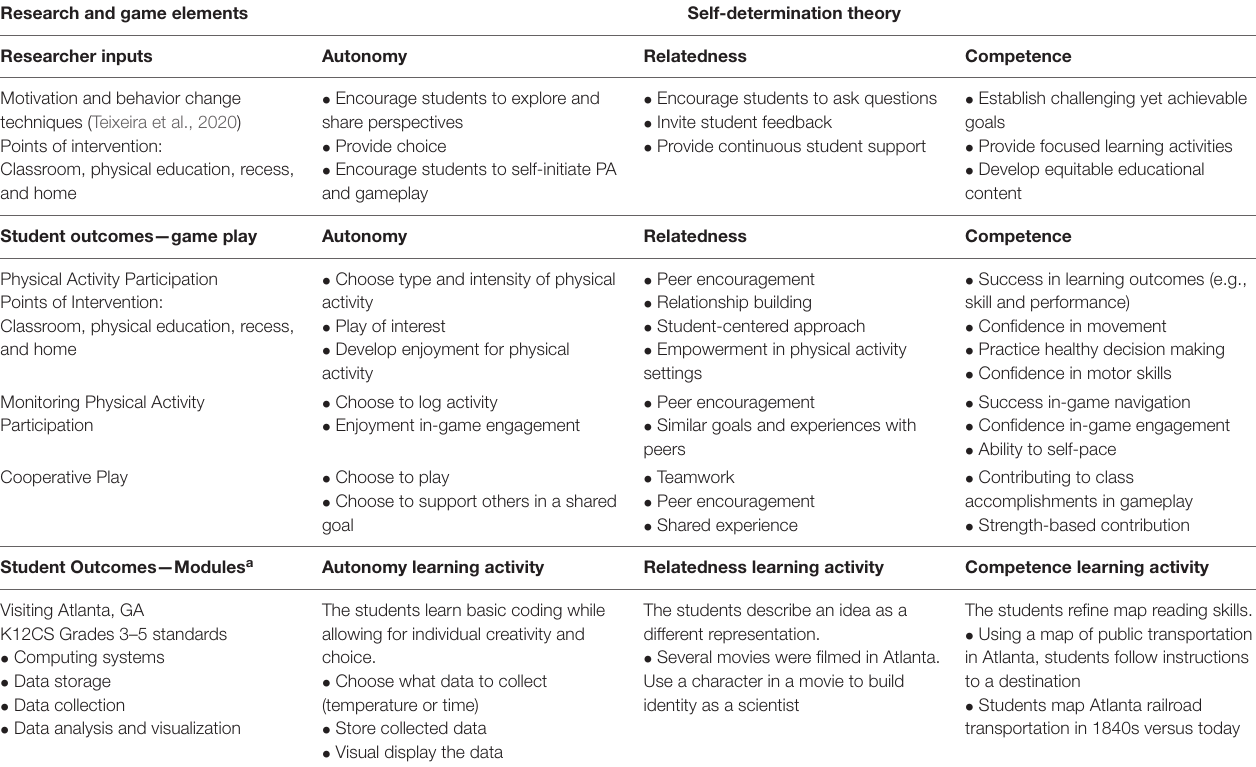
TABLE 3 | Motivation and behavior change